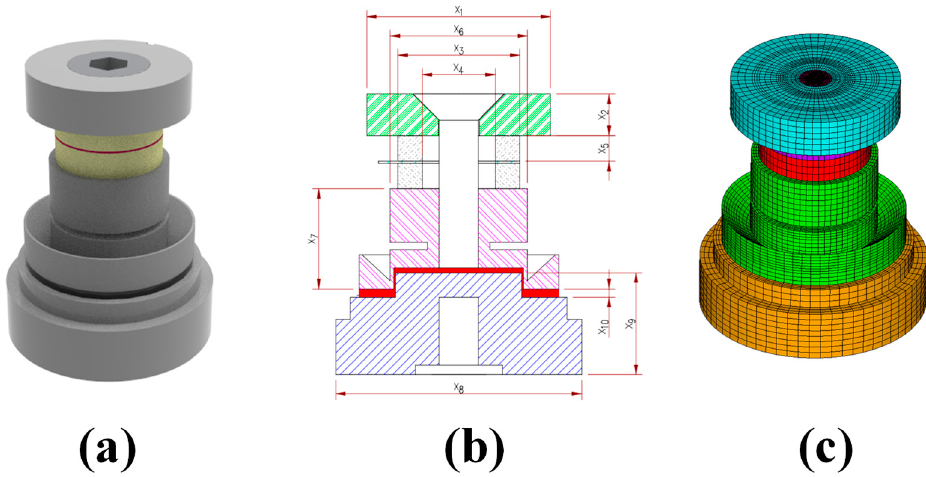
Figure 1. ( a ) Three-dimensional model; ( b ) cross-section; ( c ) finite element model of the compression- type accelerometer sensor.